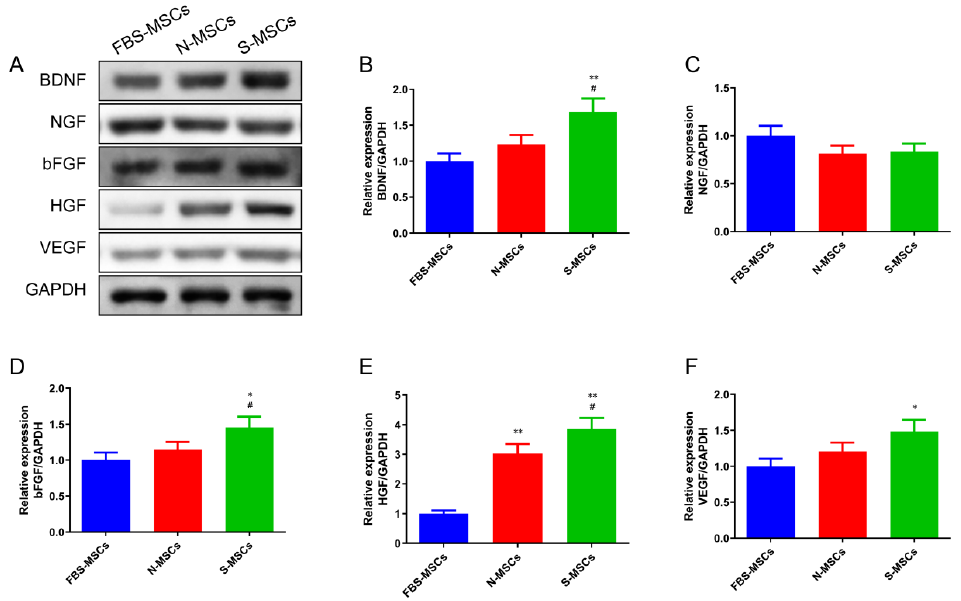
Figure 3. Comparative analysis of paracrine factors secreted by MSCs after pretreatment of rat cerebral infarction tissue: ( A ) Western blot analysis of the expression of brain-derived neurotrophic factor (BDNF) ( B ), nerve growth factor (NGF) ( C ), basic fibroblast growth factor (bFGF) ( D ), (hepatocyte growth factor) HGF ( E ), and vascular endothelial growth factor (VEGF) ( F ) in MSCs cultured with FBS, normal ischemic brain tissue, or ischemic brain tissue ( x ± s , n = 3). * p < 0.05, ** p < 0.01, compared with FBS-MSCs group; # p < 0.05, compared with N-MSCs